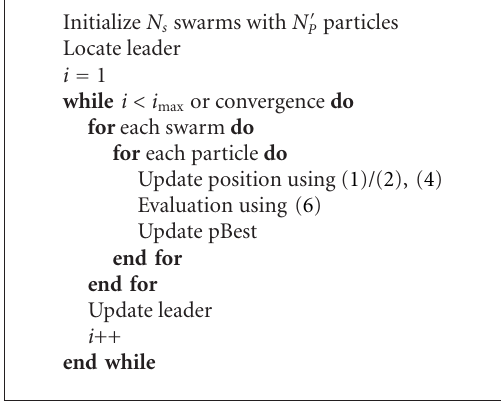
Algorithm 2: Cooperative PSO